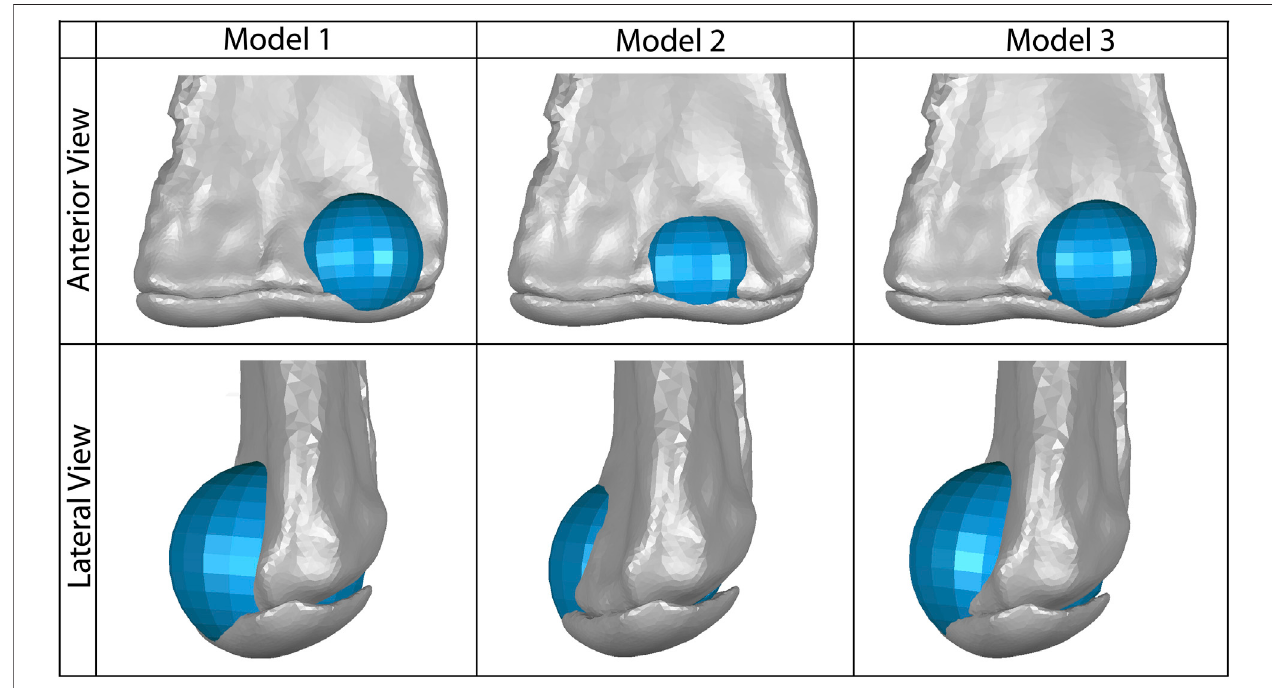
FIGURE 3 | Our three models of possible placement of the anterior spherical projection of articular cartilage (shown in blue) on the lateral distal condyle of the humerus, which would articulate with the proximal end of the radius. Model one represents the greatest anteroposterior breadth of this cartilage and the most lateral placementofthesphere.Modeltworepresentstheleastanteroposteriorbreadthofthiscartilageandthemostmedialplacementofthesphere.Modelthreerepresentsa moderate breadth and position of this cartilage sphere. The 2% thick articular cartilage on the distal end of the humerus is also shown in gray; the cartilage sphere was also positioned proximodistally to align smoothly with the curve of this humeral cartilage in lateral view.